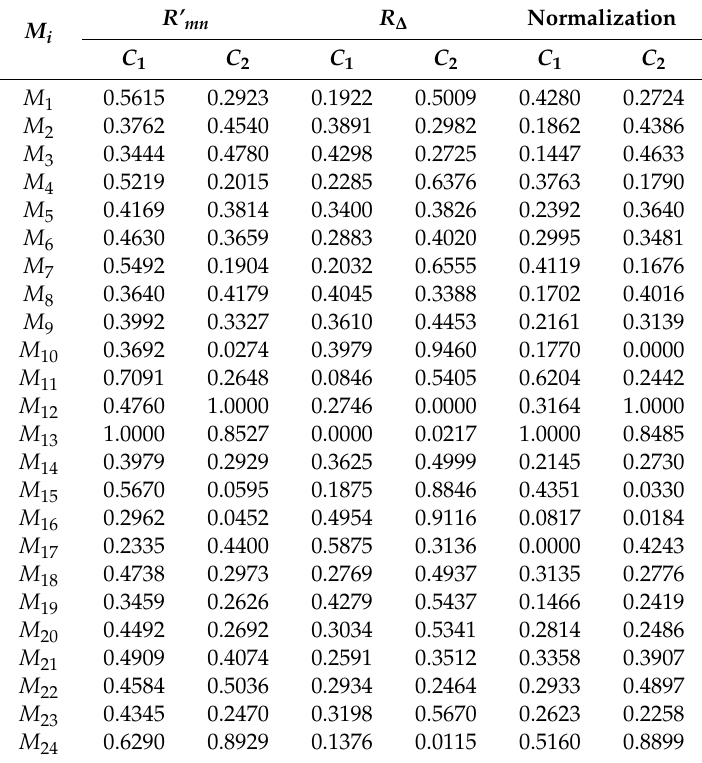
Table 2. The results of fuzzy membership, standard fuzzy matter-element and variance compound fuzzy matter-element matrix QAs.